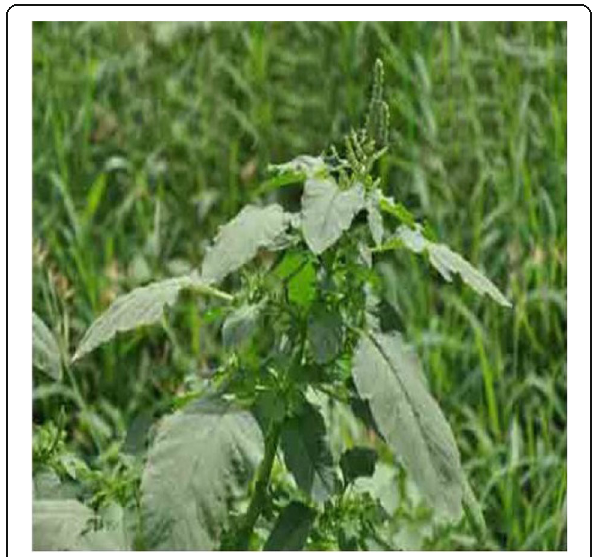
Fig. 2 Amaranthus spinosus . This endangered species belongs to the plant family Amaranthaceae (Copy source Jacob Thomas Pandalayil)